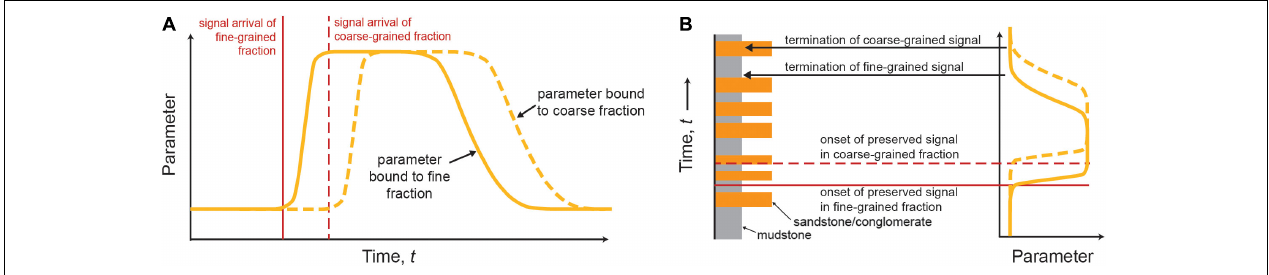
FIGURE 6 | Hypothetical behavior of signal arrival times in the deposition area if signal transfer times vary with hydraulic grain size fractions . Time of signal arrival of two signals bound to different hydraulic grain size fractions in (A) representation of parameter expression versus time and (B) schematic expression in the stratigraphic record. This is one expression of many possible scenarios and is not meant to imply a general prediction (see text for